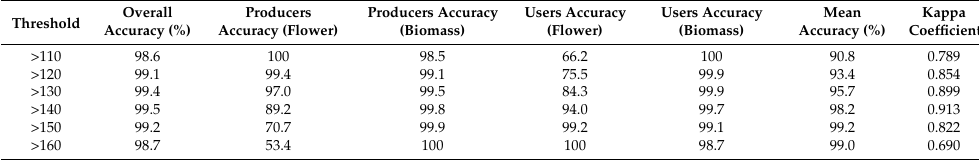
Table A1. Accuracy assessment of flower detection by UAV in 3 m flying altitude above crowns. Therefore 12,500 pixels were analyzed (ImageJ segmentation versus user/visual inspection of flowers) and two classes were used: Flower and Biomass. In the blue channel for six different thresholds is calculated the Overall Accuracy, the Producer Accuracy (Omission Error), the Users Accuracy (Commission Error), the Mean Accuracy, and the Kappa